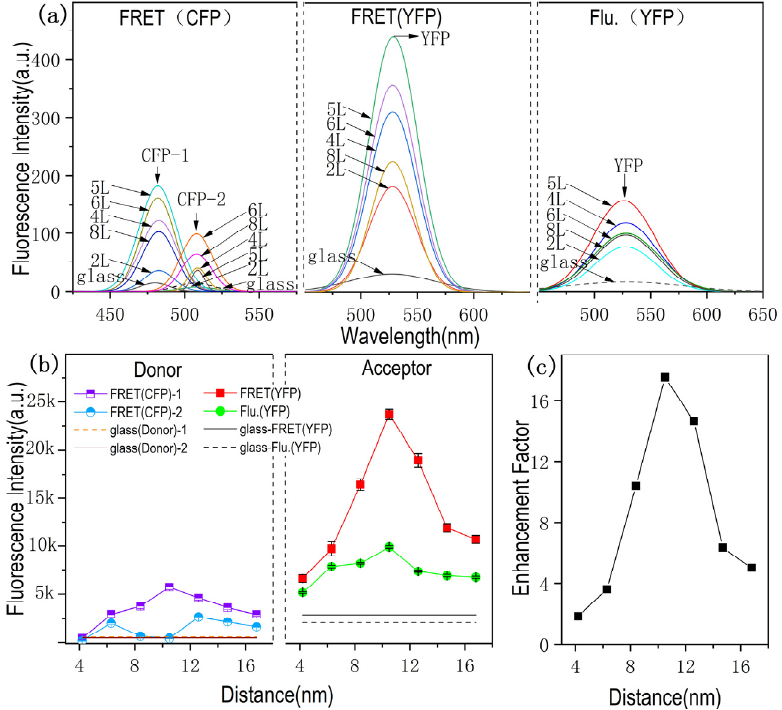
Figure 4. Fluorescence spectra and Enhancement Factor. ( a ) Fluorescence spectra of donor(CFP)- acceptor(YFP) with different distance to NPG 38nm and YFP Fluorescence spectrum of only acceptor at different distance on NPG38. ( b ) The fluorescence intensity of FRET-Donor(left), FRET(Acceptor) and YFP fluorescence intensity (right). ( c ) Enhancement Factor of FRET is calculated by Formula (2).